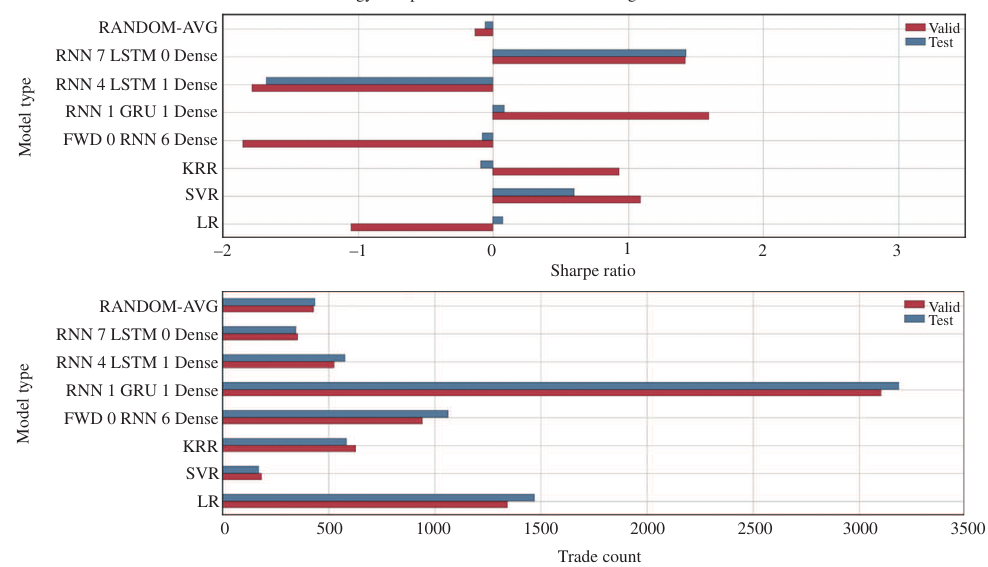
Figure 6: Performance of Regression Models on 240-Min Exit